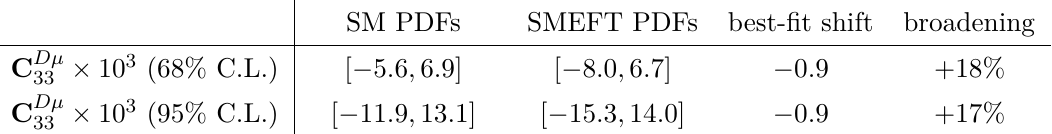
Table 3 . Same as table 1 for the 68% C.L. and 95% C.L. bounds on the C Dµ including both linear and quadratic terms in the SMEFT